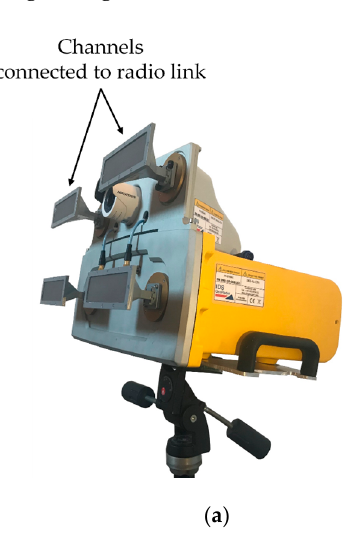
Figure 6. Pictures of the equipment used for testing of the multi-monostatic interferometric radar with radio link: ( a ) the IBIS-FM MIMO radar [12], ( b ) an example of transponder. The antennas used are standard horn antennas with the same gain of about 15 dB.